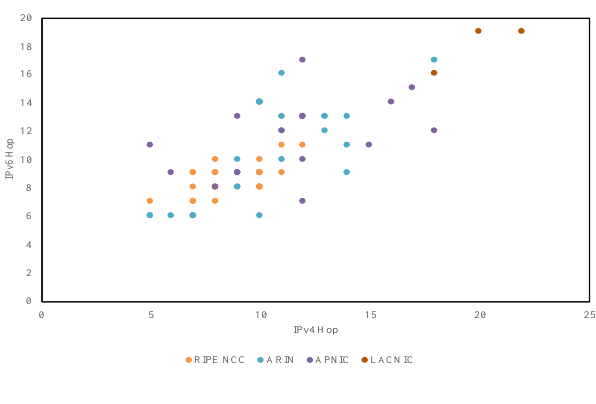
Fig. 16. Hop count test result